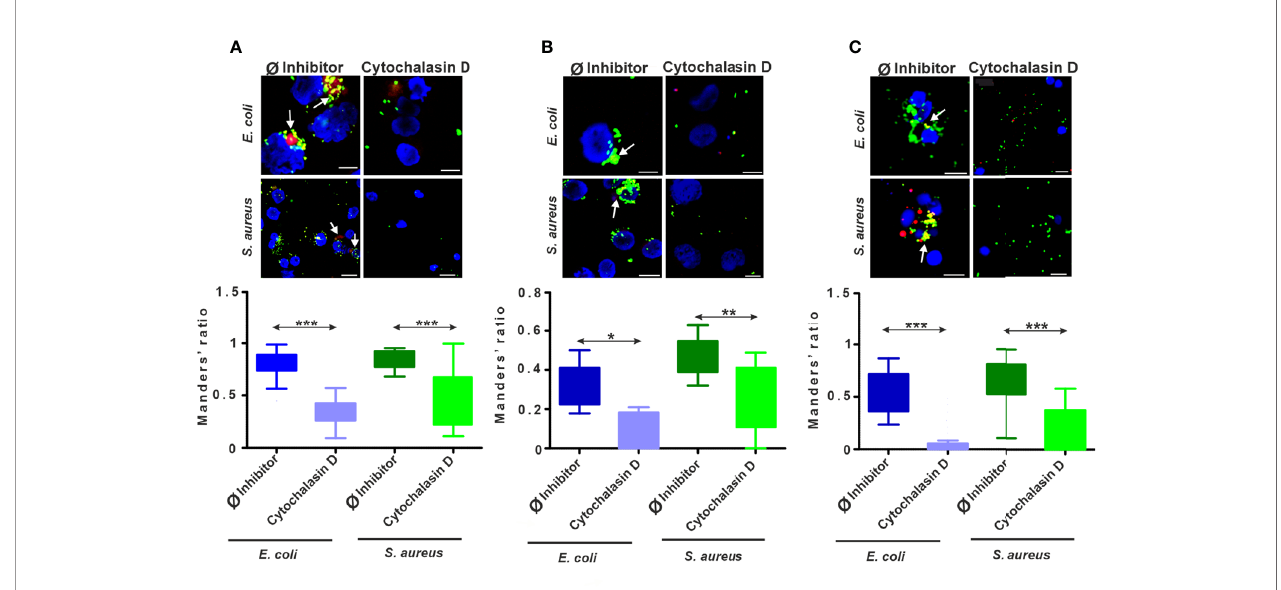
FIGURE 4 | The intracellular colocalization of lysosomes and bacteria is biased upon endocytosis inhibition. Representative CLSM images and Manders ’ colocalization coef fi cients ratios for (A) THP-1 cells, (B) diff. THP-1 cells, and (C) coelomocytes after 24 h incubation with bacteria in the absence or the presence of 5 µM cytochalasin D. Representative images demonstrate the colocalization of FITC-coupled bacteria (green) with the LysoTracker labeled (red) lysosomes (arrows). Nuclear counterstaining was performed with DAPI (blue). Scale bars: 10 µm; 50 µm (THP-1 with S. aureus ). The corresponding graphs show the fraction of colocalized E. coli /lysosomes and S. aureus /lysosomes. Results are presented as mean ± SD from three independent experiments. Asterisks point out statistical signi fi cance (* p < 0.05, ** p < 0.01, *** p < 0.001) between the Ø inhibitor control and cytochalasin D exposed